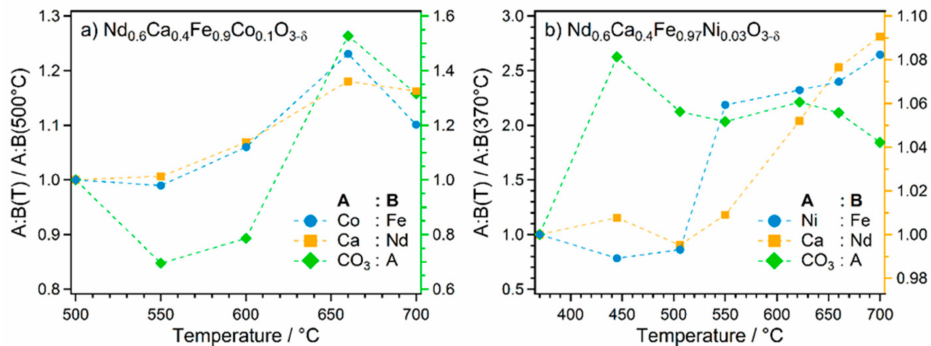
Figure 9. Elemental trends during the NAP-XPS experiments at increasing temperature for of the respective peak areas relative to the ratio at the lowest temperature. Note that the right axis with a different scaling is used for the CO 3 :A ratio in ( a ), and for the Ca:Nd ratio in ( b